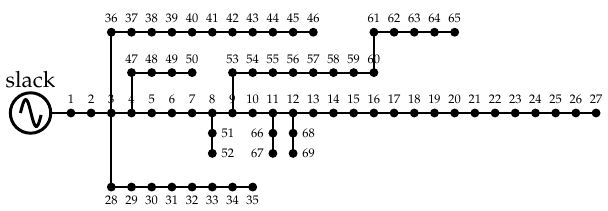
Figure 4. IEEE 69-node test feeder topology. Table 3. The IEEE 69-node test feeder